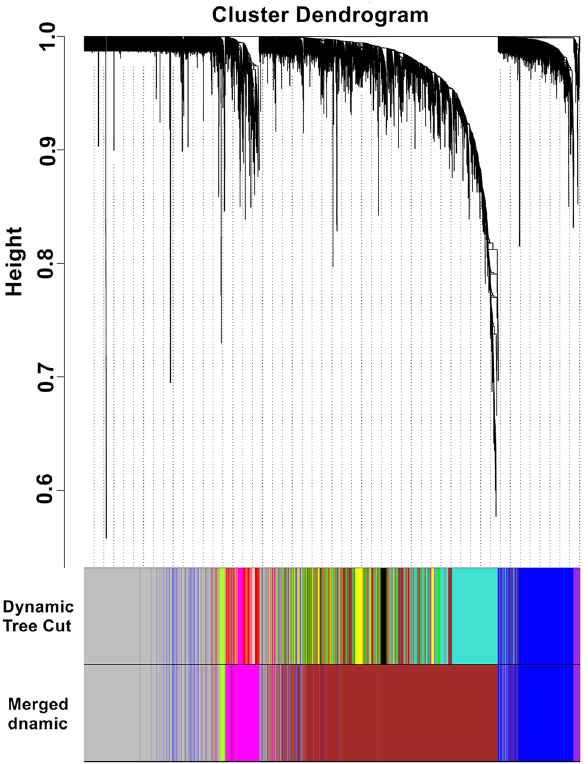
Figure 3. Clustering dendrogram of genes. Gene clustering tree (dendrogram) obtained by hierarchical clustering of adjacency-based dissimilarity. The colored row below the dendrogram indicates module membership identified by the dynamic tree cut method, together with assigned merged module colors and the original module